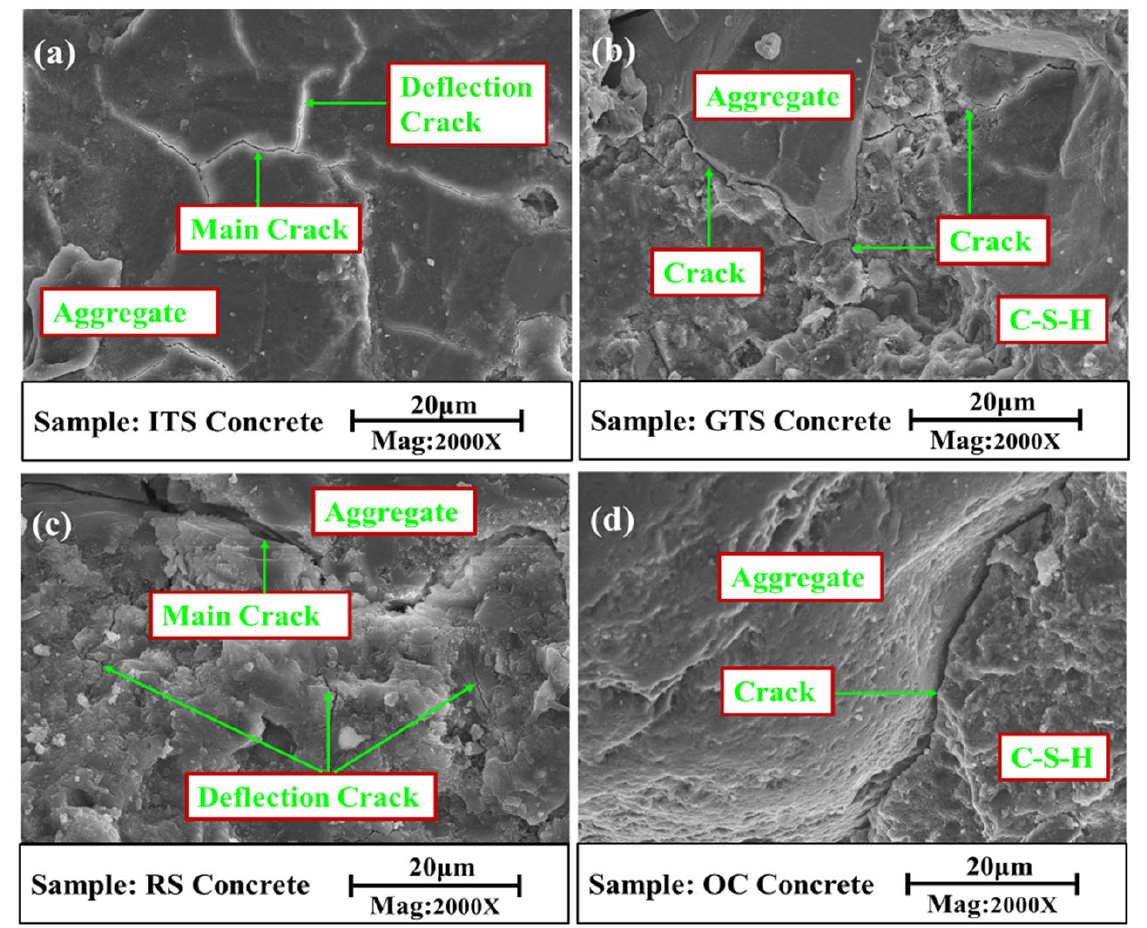
Figure 10. Propagation paths of microcracks in concrete ( a ) ITS sand concrete, ( b ) GTS sand concrete, ( c ) RS sand concrete, ( d ) Ordinary concrete.